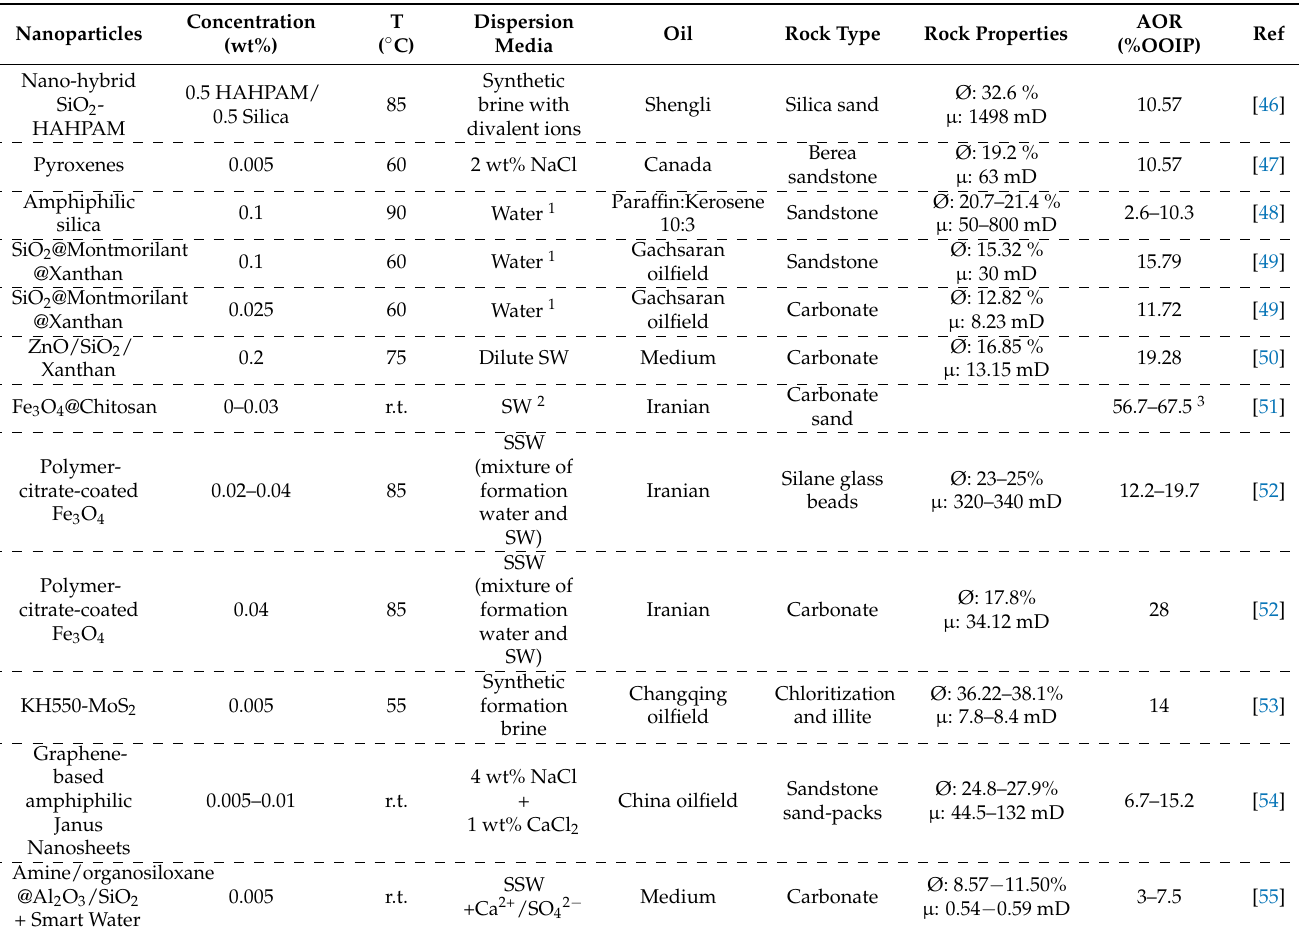
Table 2. Core-flooding tests involving functionalized